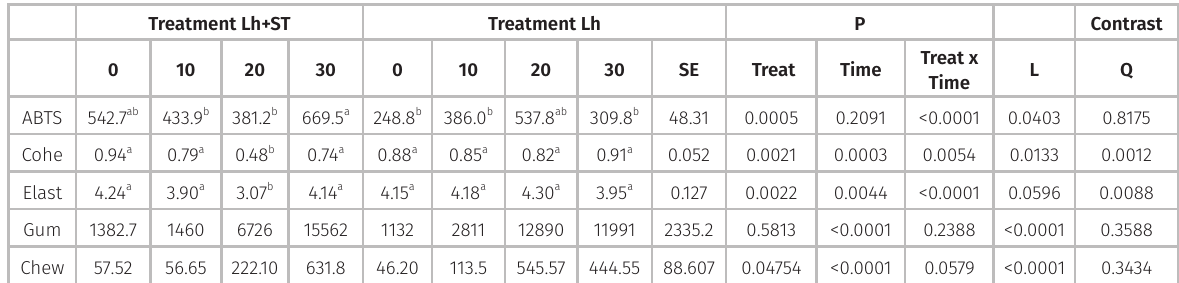
* Treatment Lh+ST: Lactobacillus helveticus and Streptococcus thermophilus ; Treatment Lh: Lactobacillus helveticus. Cohe: cohesiveness; Elast: elasticity; Gum: gum; Chew: